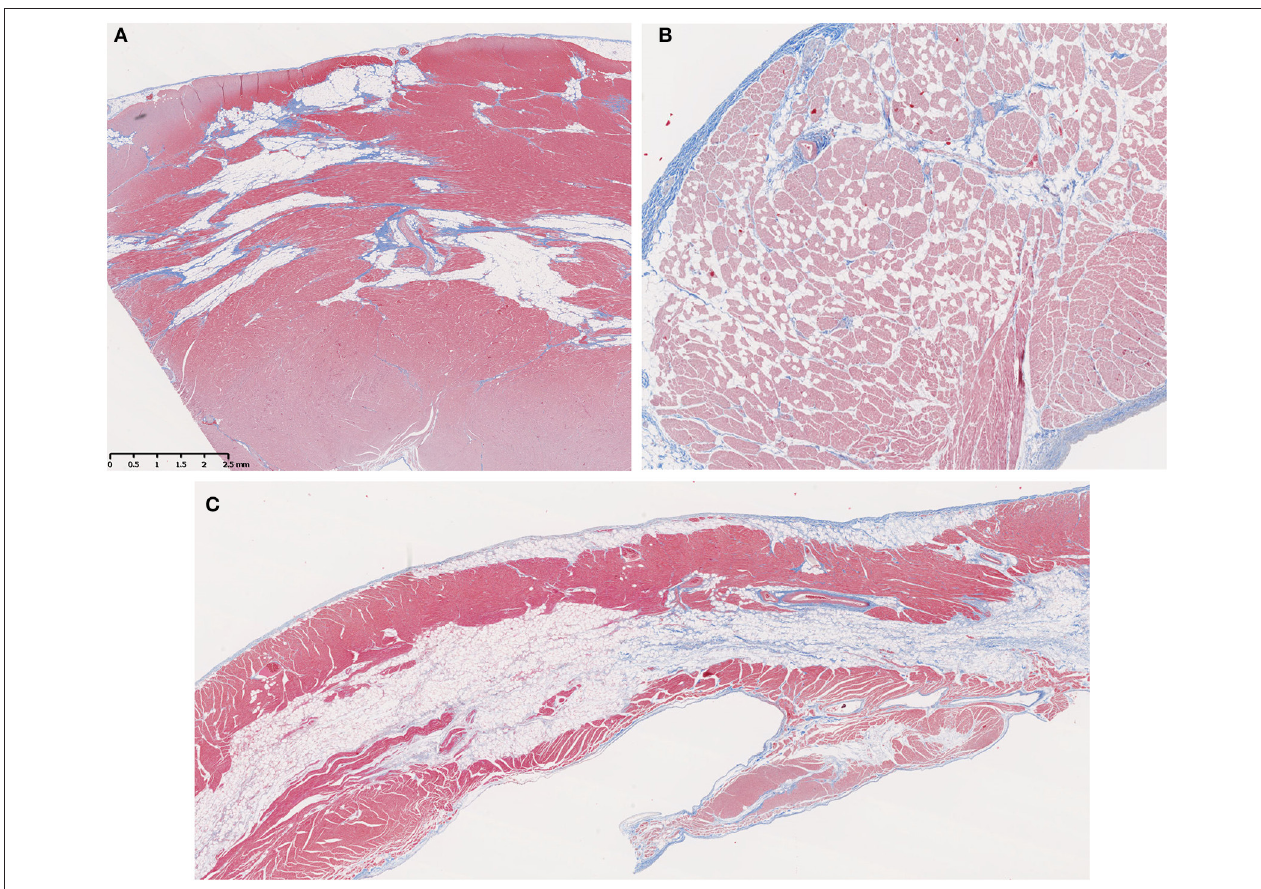
FIGURE 3 | Fatty infiltration was a prominent feature in older Golden Retriever muscular dystrophy (GRMD) dogs. (A) A section of left ventricle free wall from a 3-years-old female GRMD dog shows large bands of fat (non-staining vacuolated tissue) replacing normal myocardial muscle (red) and predominating over fibrosis (blue). (B) In some cases, fatty infiltration was more diffuse with individual or small clusters of fat cells scattered throughout the myocardium (male, 1-year-old). (C) In several dogs, the RV showed striking mid-myocardial replacement by bands of fat with minimal fibrotic tissue (male, 3.5-years-old). In these trichrome-stained sections, muscle fibers = red, collagen = blue, and fat cells = non-staining vacuolated tissue; × 10 original